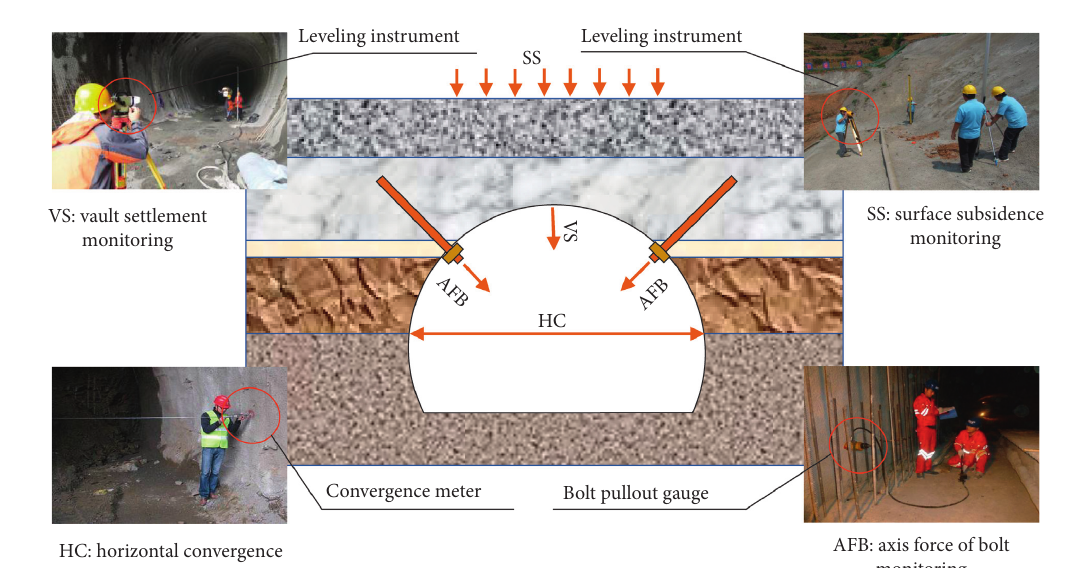
Figure 2: Traditional monitoring data acquisition.